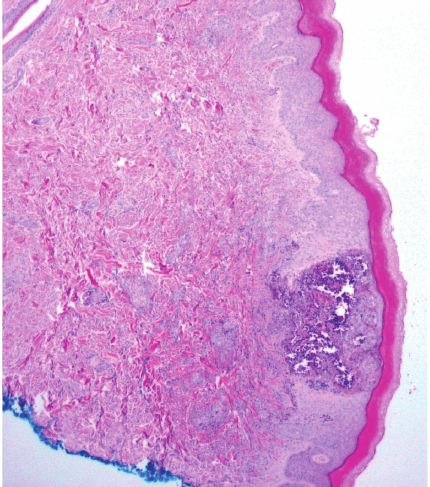
Figure 6: Histopathology of HSP involvement in skin showing microabscess.